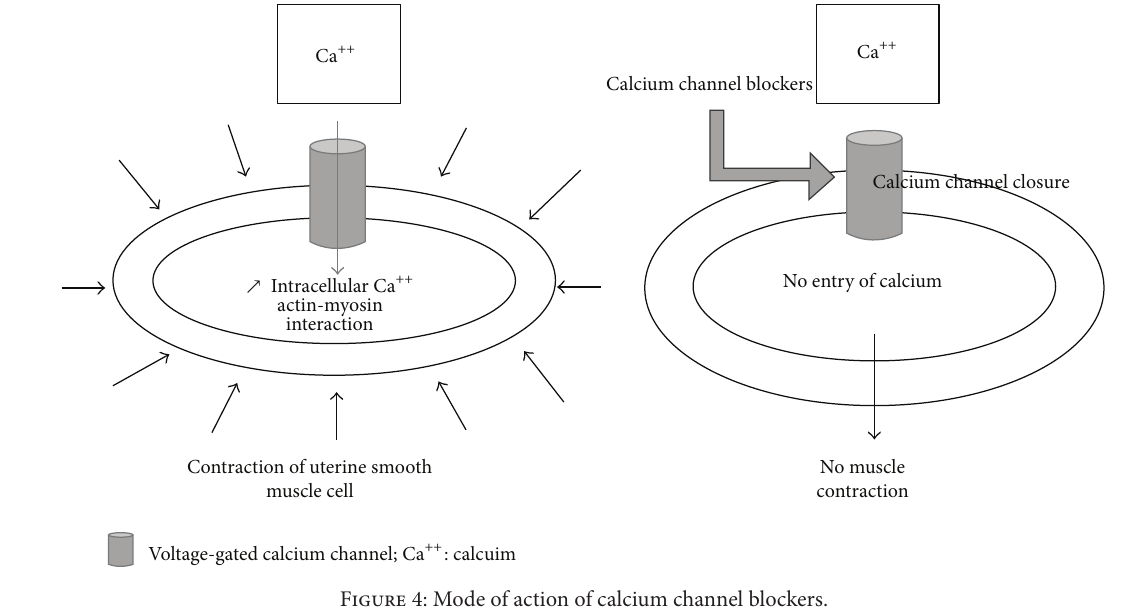
Figure 4: Mode of action of calcium channel blockers.